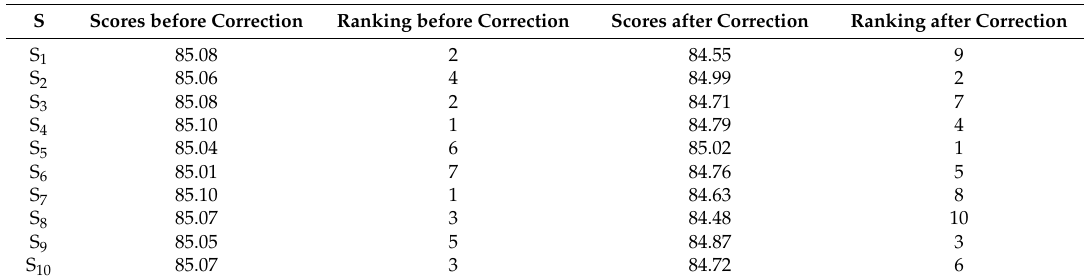
Table 6. Comparison of scoring before and after